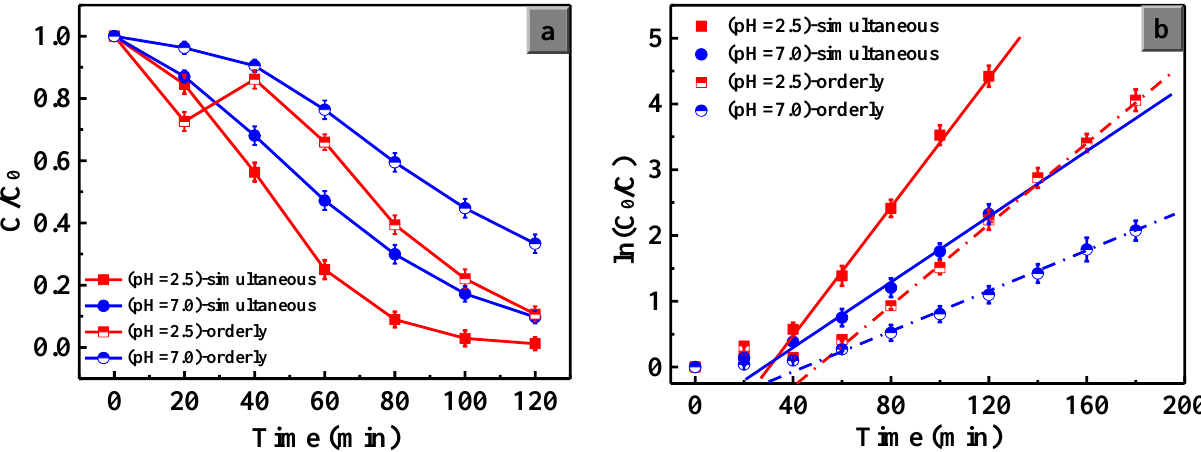
Figure 9. The comparison of catalytic behaviors for CuO under light irradiation with different ways of adding H 2 O 2 . ( a ) C/C 0 of MO vs. time; ( b ) first-order kinetic plot of ln(C 0 /C) vs. time. The apparent first-order rate constant, k app = Kk can be determined from Langmuir– Hinshelwood kinetics at low initial dye concentrations, where K is the adsorption equilib- rium constant of the dye and its intermediates and k is the reaction rate constant. In the